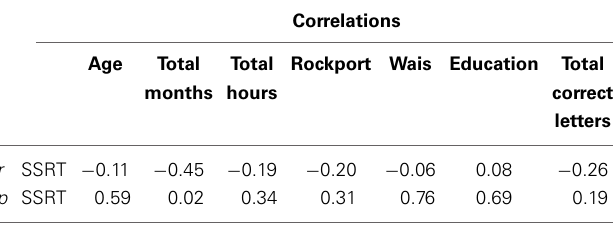
Table 3 | Correlations found between inhibition and multiple